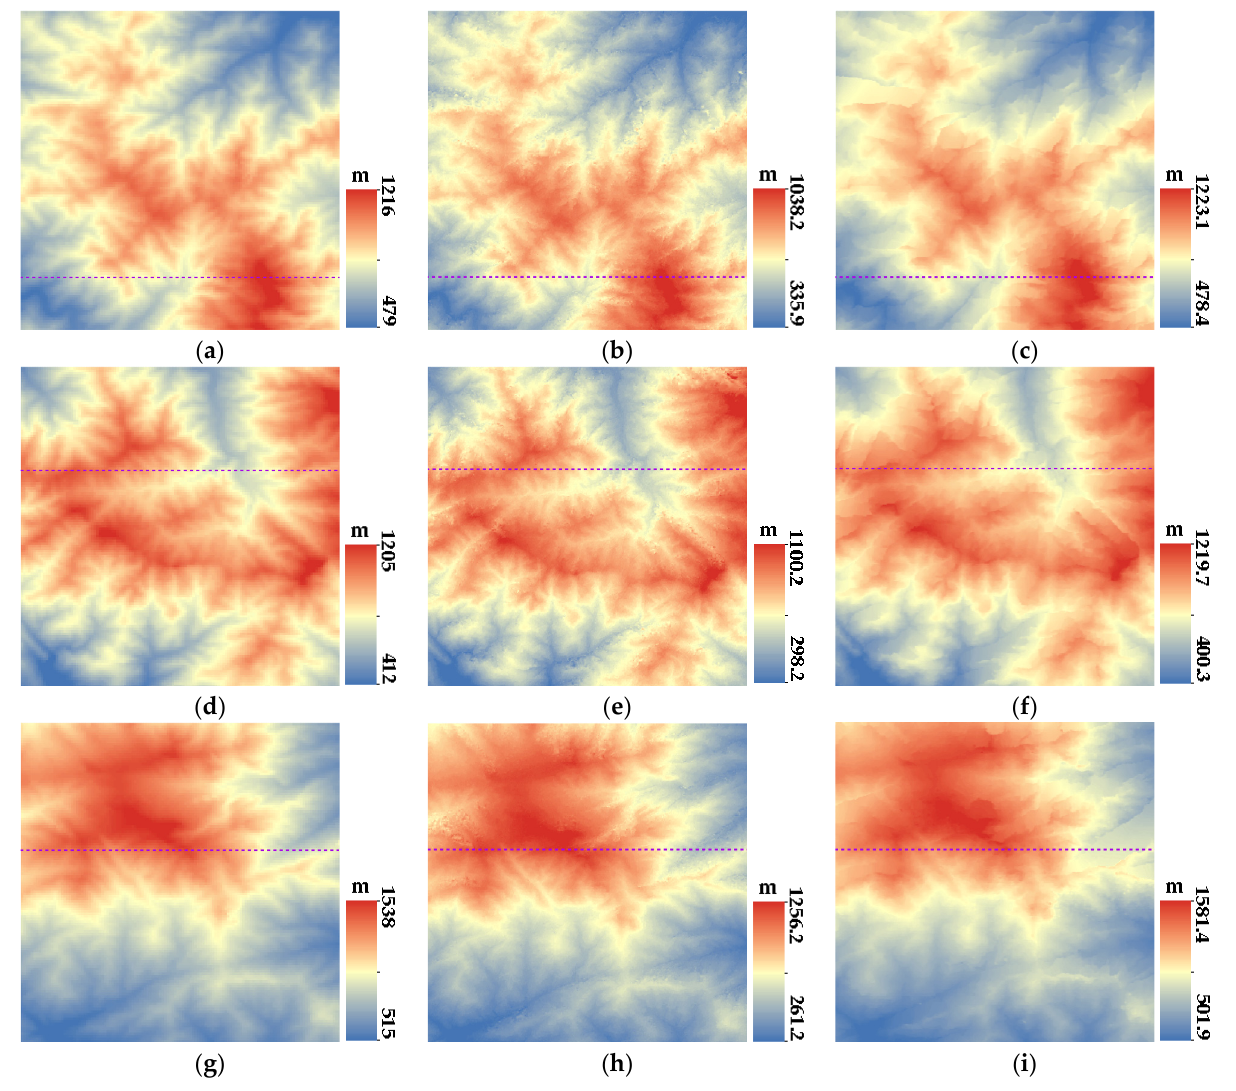
Figure 9. DSM of mountain peak regions: ( a ) Reference DEM of peak region 1; ( b ) DSM extracted by ENVI of peak region 1; ( c ) DSM of this paper of peak region 1; ( d ) Reference DEM of peak region 2; ( e ) DSM extracted by ENVI of peak region 2; ( f ) DSM of this paper of peak region 2; ( g ) Reference DEM of peak region 3; ( h ) DSM extracted by ENVI of peak region 3; ( i ) and DSM of this paper of peak region 3.